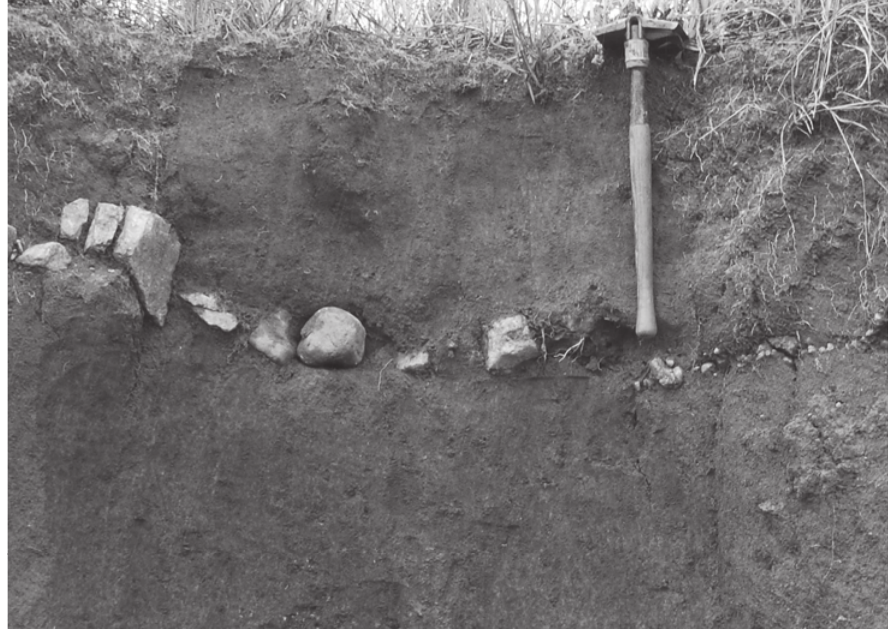
Figure 5 - Stone layer rounded and angular components of different size separating a yellowish- brown horizon and reddish horizon. Profi le in the valley of Rio Guapiaçu, municipality of Cachoeiras de Macacu